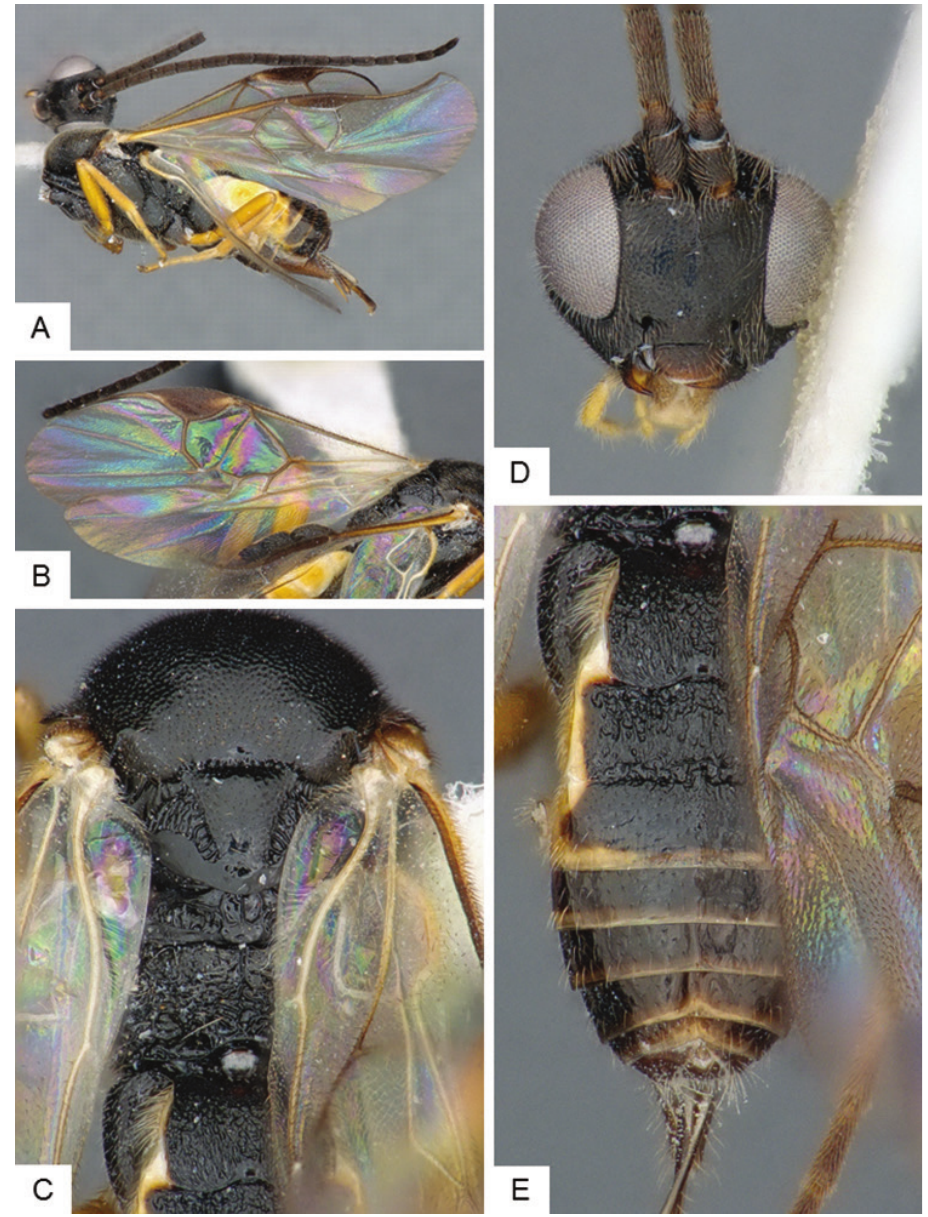
Figure 6. Cotesia sp. 3. A Habitus, lateral B Fore wing C Mesosoma, dorsal D Head, frontal E Meta- soma,